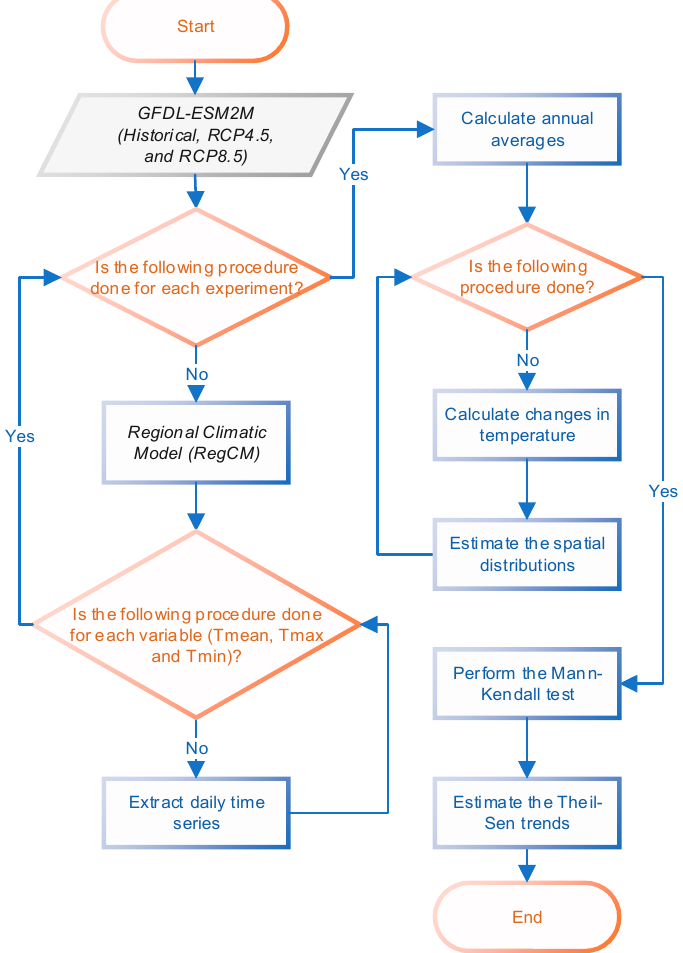
Figure 2. Methodological framework for projecting temperature